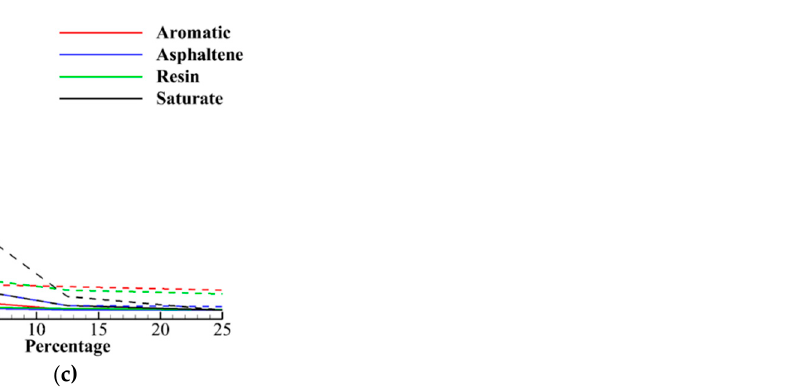
Figure 7. Diffusion of SARA and different dosages of hydrogenated and oxygenated CNTs. ( a ) SARA-hydrogenated CNTs, ( b ) SARA-oxygenated CNTs, and ( c ) comparison of SARA-hydrogenated (dashed lines) and SARA-oxygenated CNTs (solid lines).